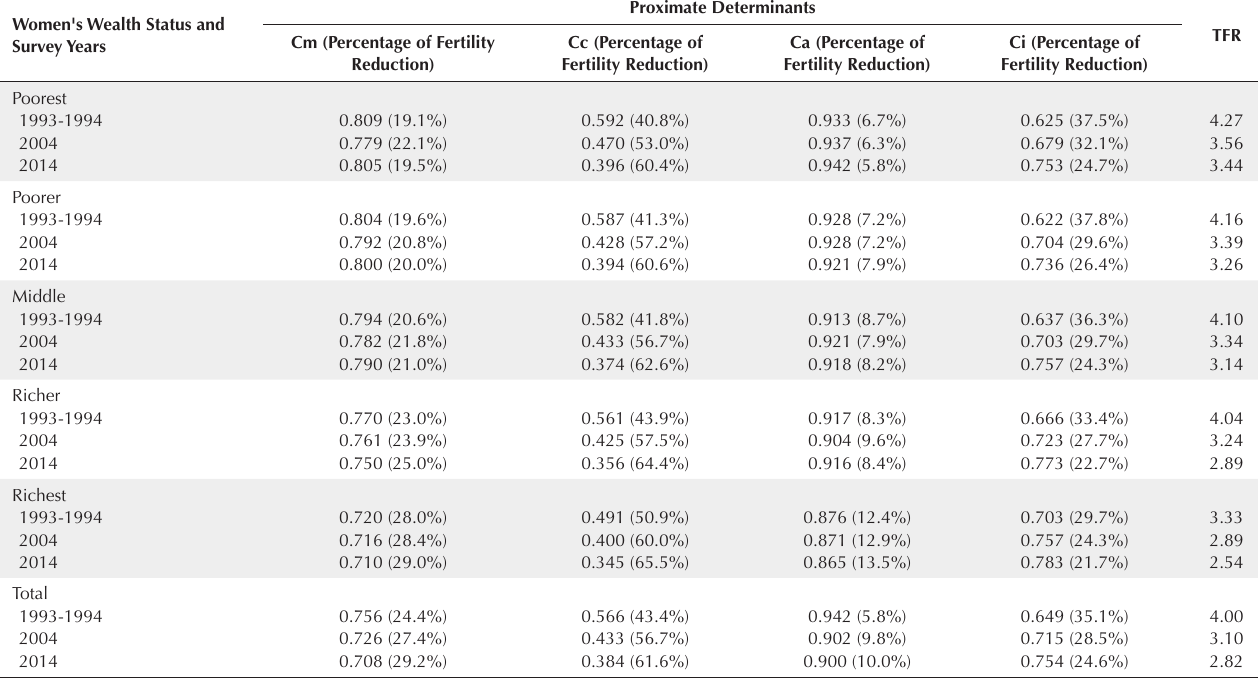
Table 4. Variations in the Proximate Determinants on Fertility Changes according to the Wealth Status of Women in Bangladesh: 1993-1994 to 2014 BDHS